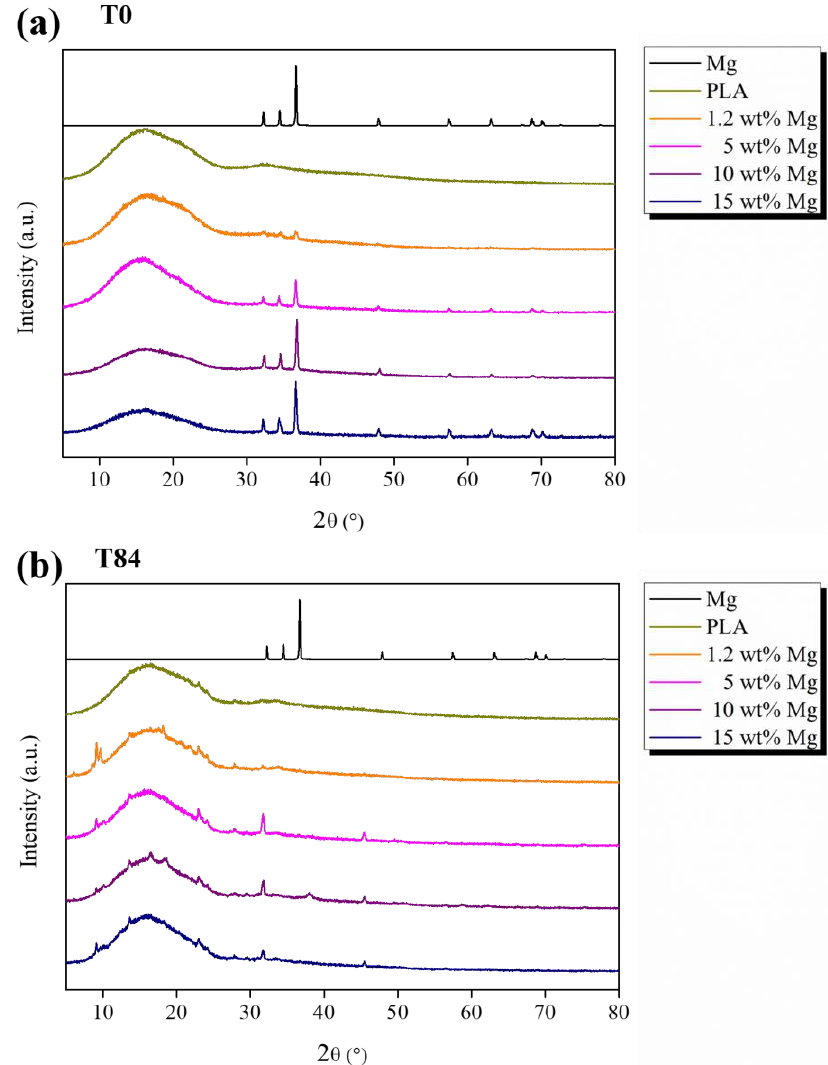
Figure 8. XRD patterns of Mg microparticles as well as PLA-Mg filaments ( a ) at T0 and ( b ) after 84 days, T84, in PBS media.